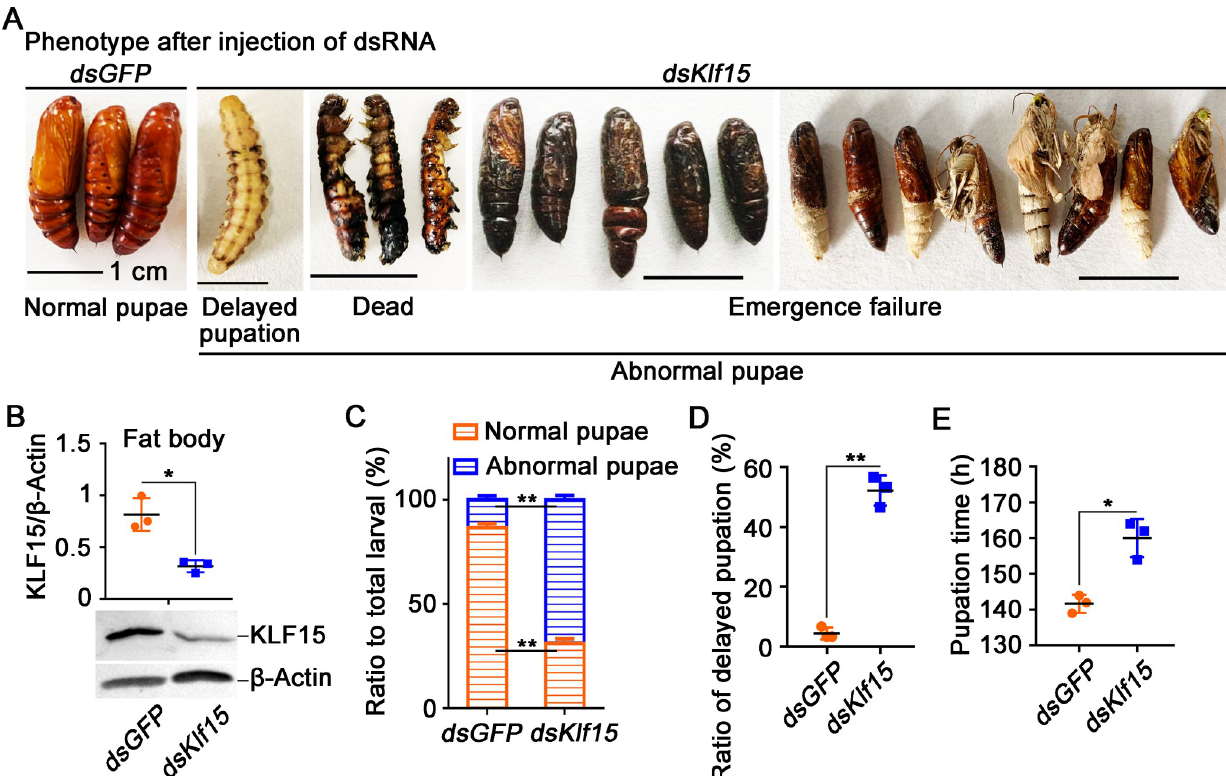
Fig 2. Knockdown of Klf15 delayed pupation. A. Phenotypes after injection of Klf15 dsRNA from 6th-6 h larva to 72 h; the ruler represents 1 cm, dsGFP was used as the control. B. Western blotting validation of the interference efficiency in the fat body after the third dsRNA injection. C. Ratio of phenotypes, abnormal pupae include larvae that die during the prepupa stage, dead pupae and chimeric pupae that cannot normally emerge. D. The ratio of delayed pupation after the dsRNA injection. E. The time at which the larvae pupated after knockdown GFP and Klf15 . The data were obtained in triplicate with thirty larvae each